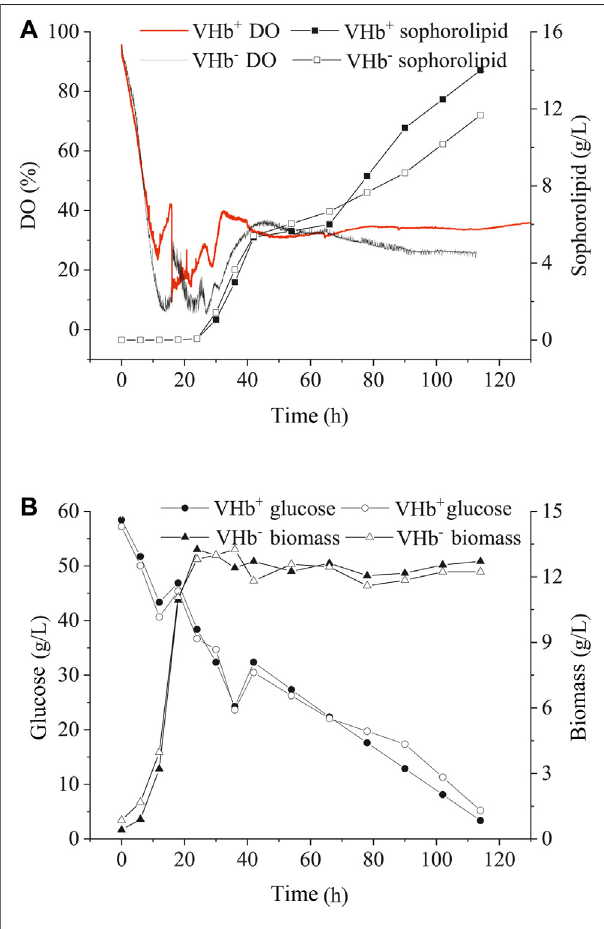
FIGURE 5 | Effects of VHb expression on DO content and sophorolipid production (A) , the residual sugar and biomass (B) under oxygen-limited